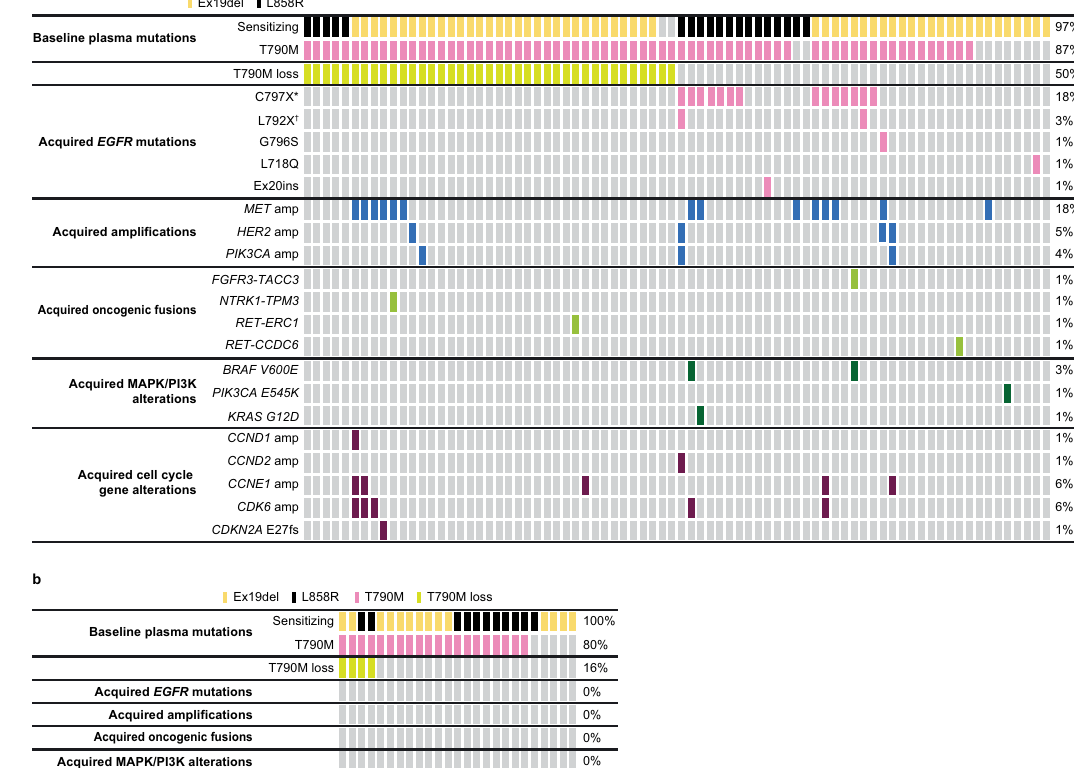
Fig. 2 | Acquired alterations in osimertinib-treated patients and in chemotherapy-treated patients. Tile plots indicating A acquired alterations in osimertinib-treated patients ( n =78) and B acquired alterations in chemotherapy-